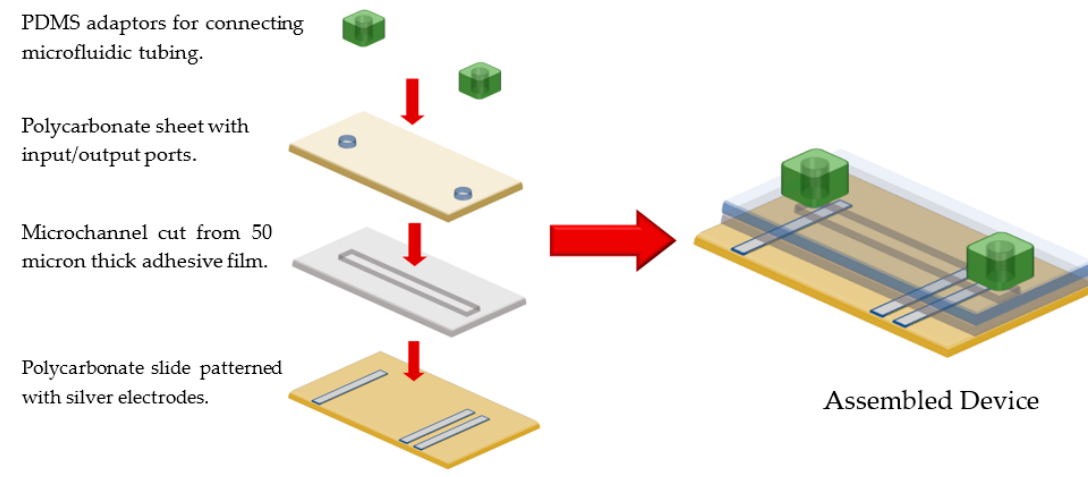
Figure 1. Assembly of microfluidic sensing device for in situ patterning of smart hydrogels.